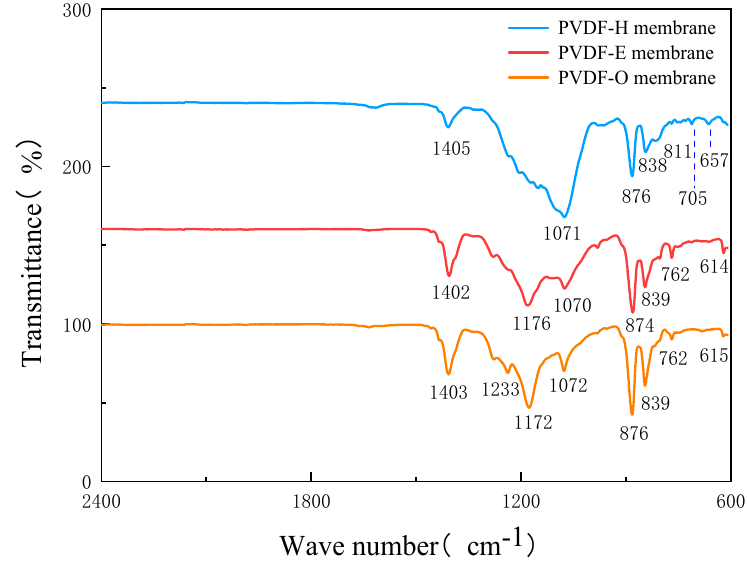
Figure 4. ATR-FTIR spectra of the PVDF-H, PVDF-E and PVDF-O membrane. In general, the membrane surface CA can be utilized to evaluate the wettability of the membrane surface. As shown in Figure 5, the contact angles of the PVDF-H and PVDF-O membranes with different liquids in air medium are compared. The results show that the WCA of the PVDF-O membrane is 153 ◦ , realizing the superhydrophobic effect. No matter what kind of test liquid is used, the contact angle of the PVDF-O membrane is higher than that of the PVDF-H membrane. Attributing this to the low surface energy property of PVDF-O membrane, hexadecane and absolute ethanol droplets cannot wet the membrane immediately when they contact the surface.